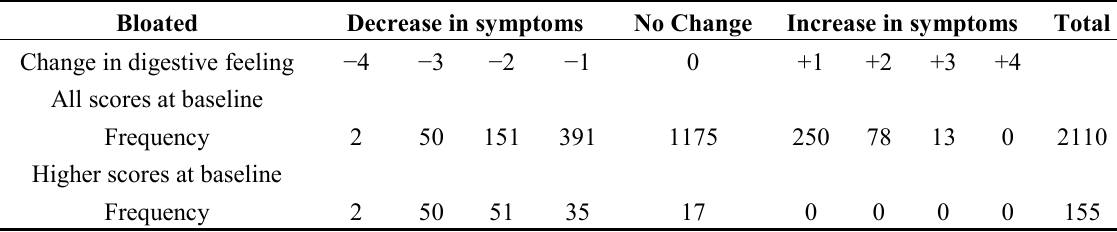
Table 6. The shifts in scores of the digestive feeling “bloated” from the baseline to the fibre intervention period for all participants with data at both time points. Change 1 frequencies are shown for participants with any score at baseline (all scores) and for participants with higher scores (≥3) at baseline (extreme scores). Bloated Decrease in symptoms No Change Increase in symptoms